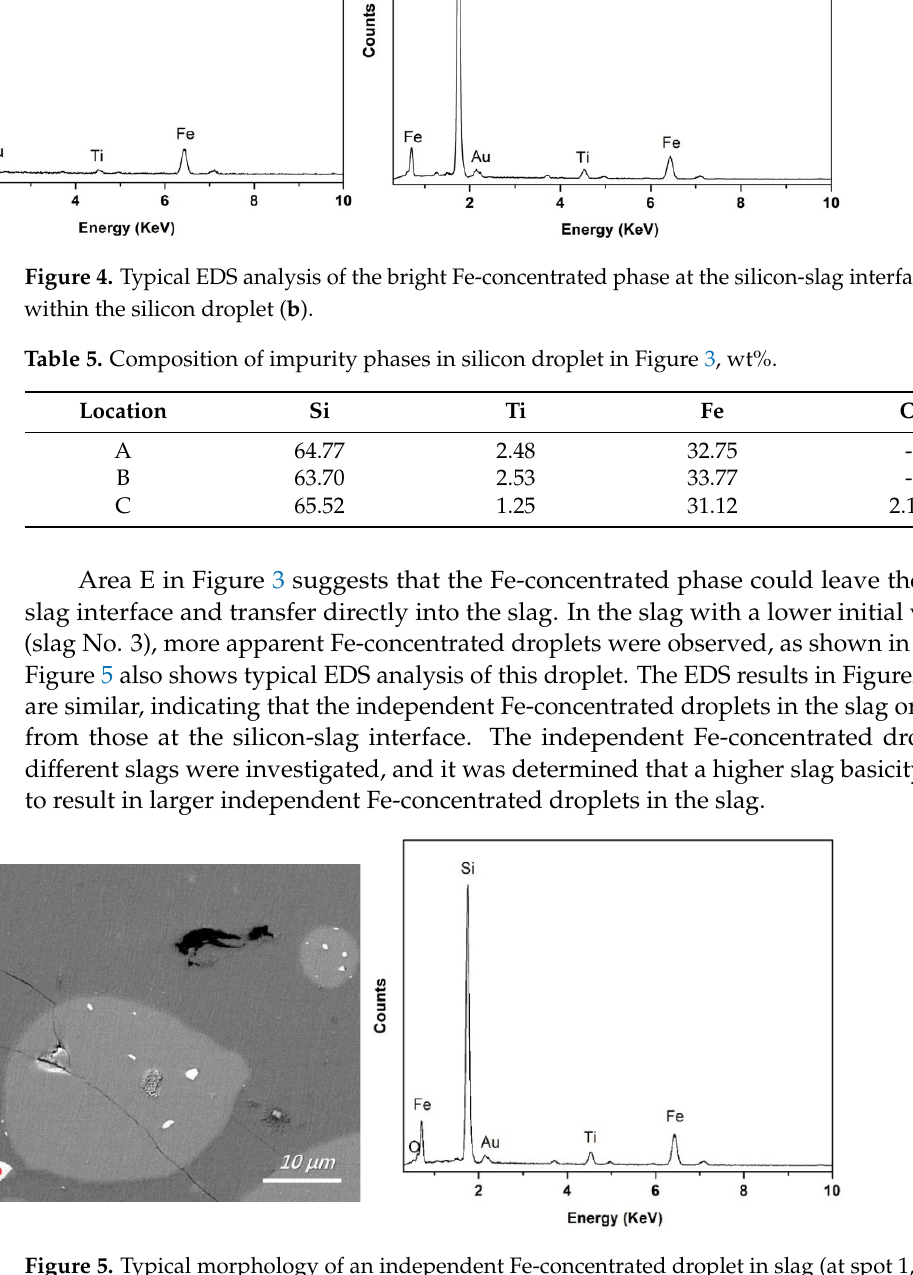
Figure 5. Typical morphology of an independent Fe-concentrated droplet in slag (at spot 1, backscat- tered electron image) and the corresponding EDS analysis at spot 1.